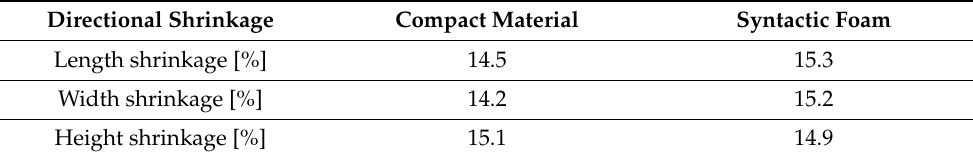
Table 5. Results of shrinkage measurements.